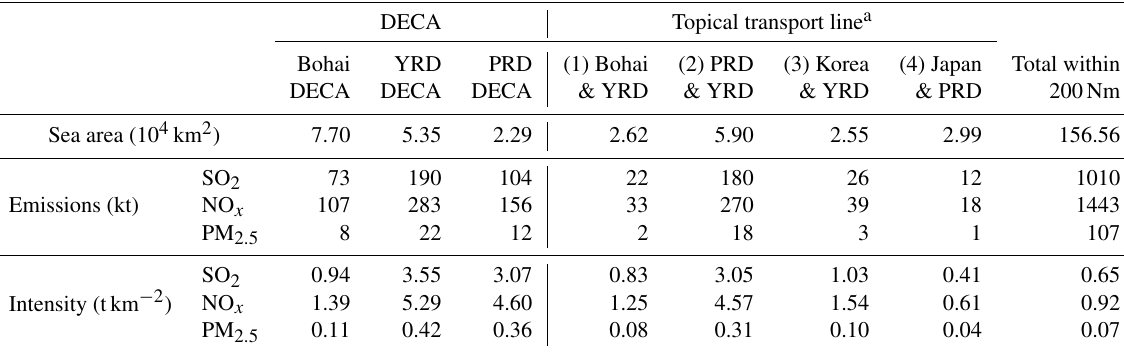
∗ Geographic location of transport lines shown in Fig. S9 in the